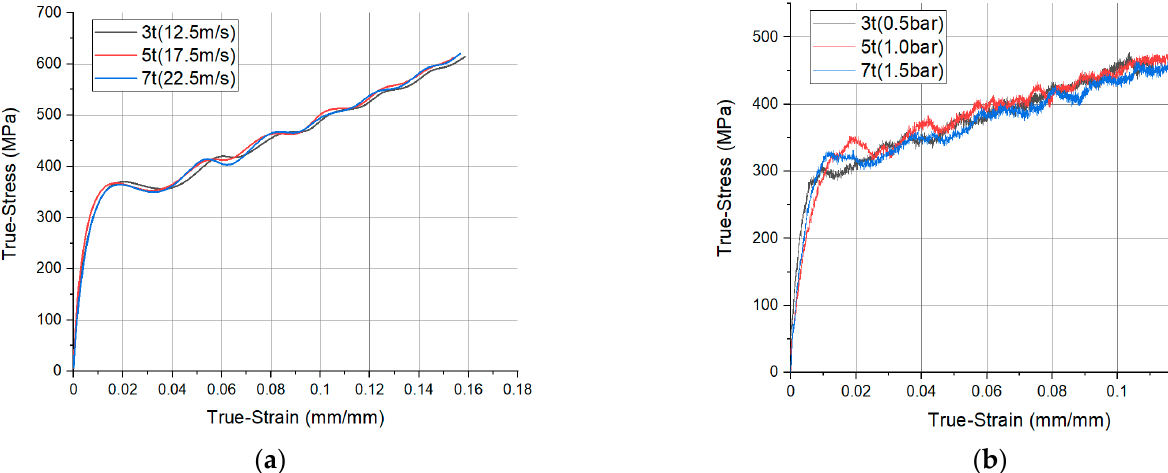
Figure 13. Comparison of the true stress and strain results in; ( a ) analysis; and ( b ) experiment under different test conditions.